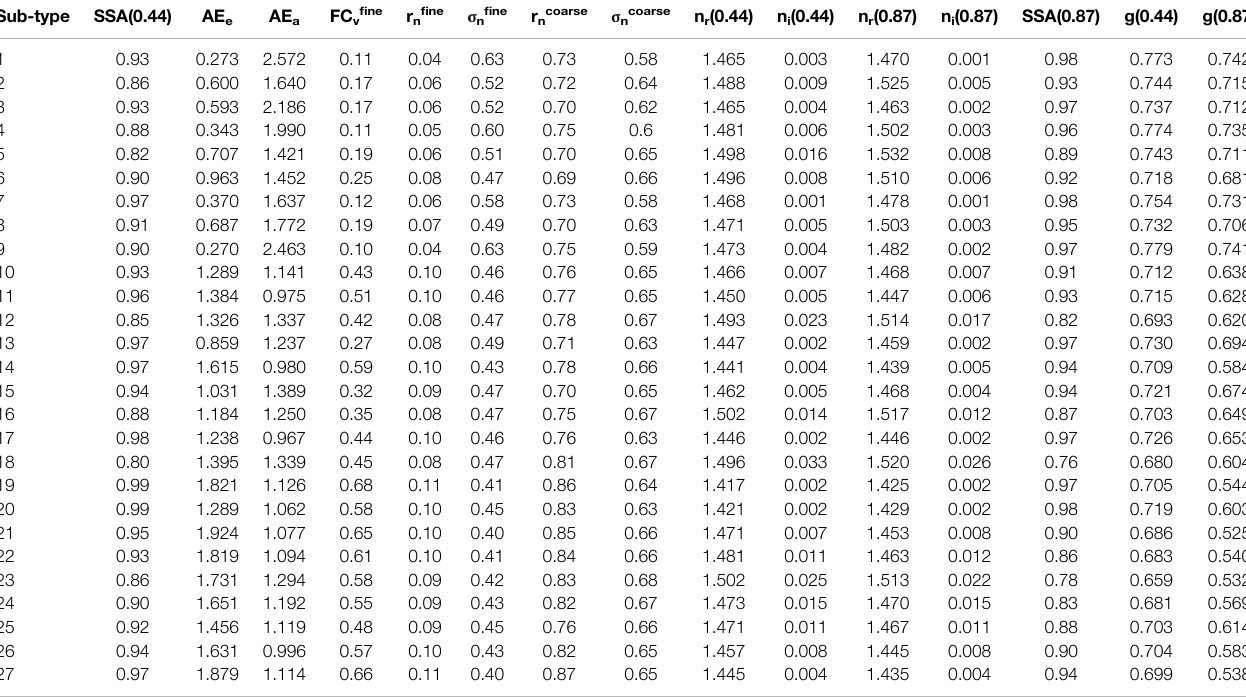
TABLE 5 | Summary of aerosol properties per cluster. Each value corresponds to the arithmetic mean. Units of properties are described in Table 1 . Sub-types 1 – 9 are DU, 10 is MAR, 11 – 15 are MIX, 16 – 21 are U/I, and 22 – 27 are BB. Sub-type